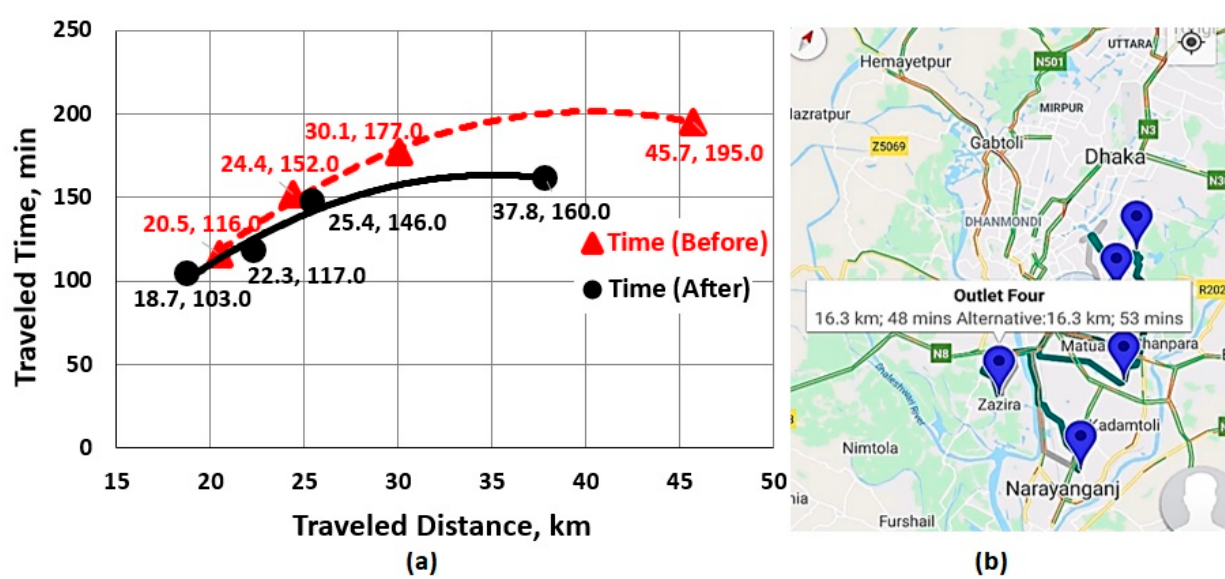
Figure 12. ( a ) Empirical relationship between traveled distance and time before and after using the intelligent routing optimizer ( b ) non-linear correlation of distance and time showing optimum routing (16.3 km, 48 min) and alternate routing (16.3 km, 53 min).